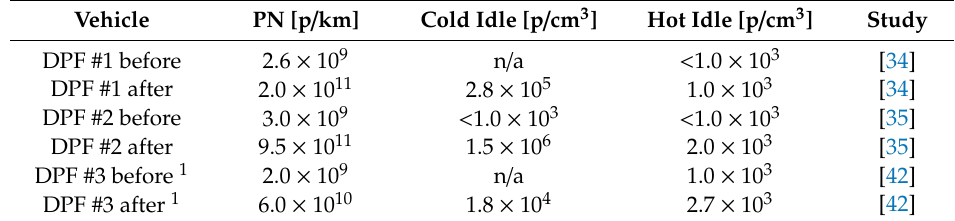
Table 3. Particle number (PN) cycle emissions and cold idle (at 120 s) and hot idle (at 1000 s) concentrations for WLTCs (Worldwide harmonized Light vehicles Test Cycle) just before and immediately after